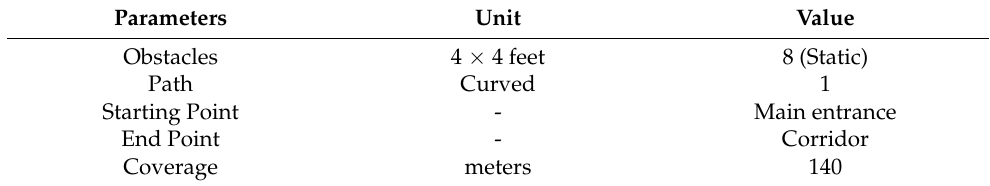
Table 2. Significant experimental parameters.